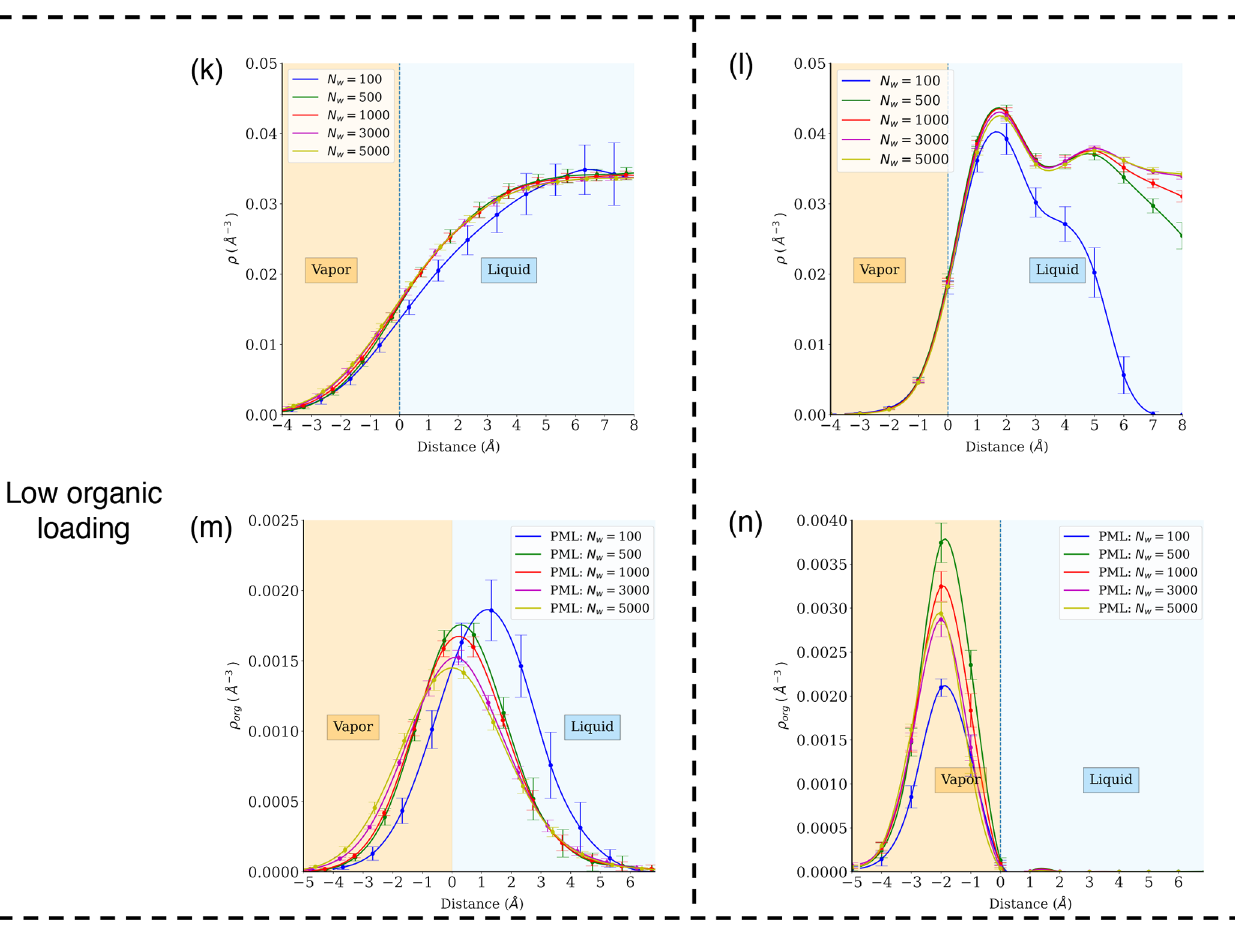
Figure A4. Atomic density profiles of different components relative to distance from the Gibbs dividing surface (a, c, g, i, k, m) and the instantaneous interface (b, d, f, h, j, l, n) . The top row (a, b) shows water density profiles in pure-water droplets. Rows 2–3 (c–f) show water and ion density profiles in droplets with 1m NaCl. Rows 4–7 (g–n) show results at other aqueous chemistries.